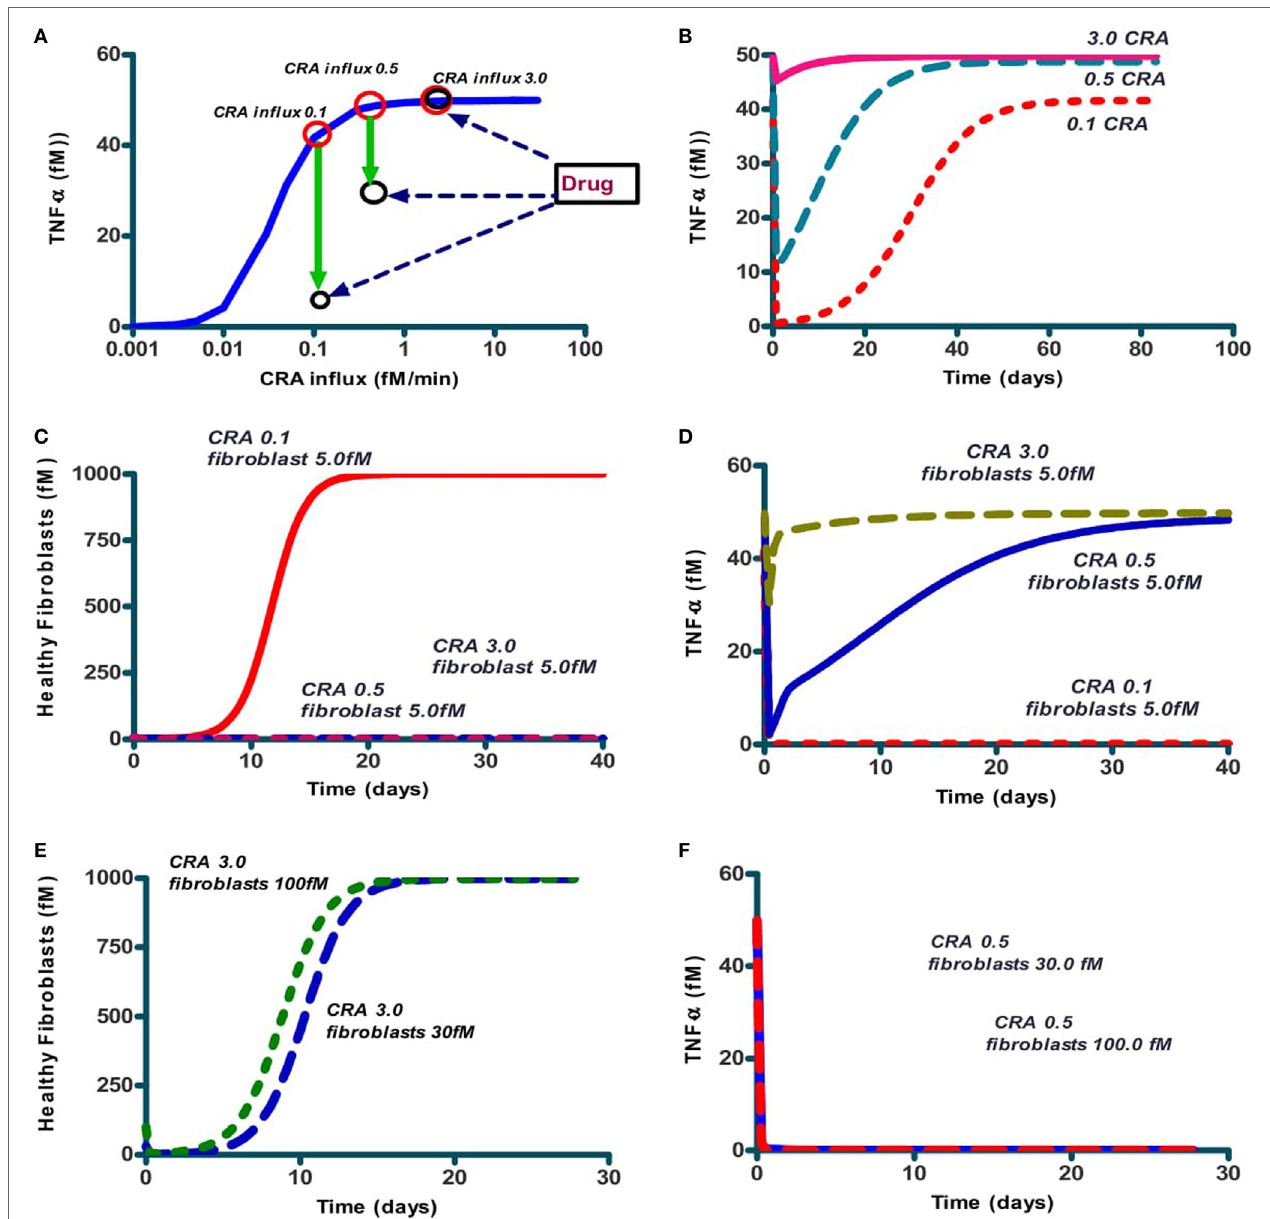
FigUre 5 | The effect on steady-state TNF- α levels and number of healthy fibroblasts of addition of IgLC-binding peptide to a chronically inflamed network at various sustained rates of CRA influx. (a) The full line (blue; also in Figure 4a ) represents the steady-state TNF- α levels when no peptide was added; the system had first been brought to the CRA influx steady state of 30 fM/min after which the CRA influx rate was reduced to the number indicated on the abscissa. This produced the chronic inflammation state even for the lower CRA influx rates. The red circles indicate these original chronic inflammation states at CRA influx rates of 0.1, 0.5, and 3.0 fM/min. The downward green arrows to the black circles show the effect after 15 simulated days, of then adding 1 nM of IgLC-binding peptide at sustained CRA influx rates of 0.1, 0.5, or 3 fM/min. (B) The time dependence of TNF- α after peptide addition to any of these three chronic inflammation states, i.e., at CRA influxes of 0.1, 0.5, and 3 fM/min. (c) The effect on fibroblast levels of 5.0 fM fibroblast addition to the system at steady state simultaneously with peptide addition, of the 0.1 (full red line), 0.5 (dashed blue line), and 3.0 (dashed red line) fM CRA/min chronic states as in (a) . (D) The effect on TNF- α levels of 5 fM fibroblasts added to the system at steady state simultaneously with drug treatment of the CRA influx of 0.1 (dashed red line), 0.5 (blue full line), and 3.0 (dashed green line). (e) Fibroblast concentration as function of time after injecting 6 times (dashed line) or 20 times (dotted line) more healthy fibroblasts to the chronic 3.0 fM CRA/min state. (F) The effect on TNF- α levels of giving 30 or 100 fM fibroblasts to the system at steady state simultaneously with peptide treatment at CRA influx rates of 0.5 (red dotted line), 3.0 fM/min (blue full line, coinciding with